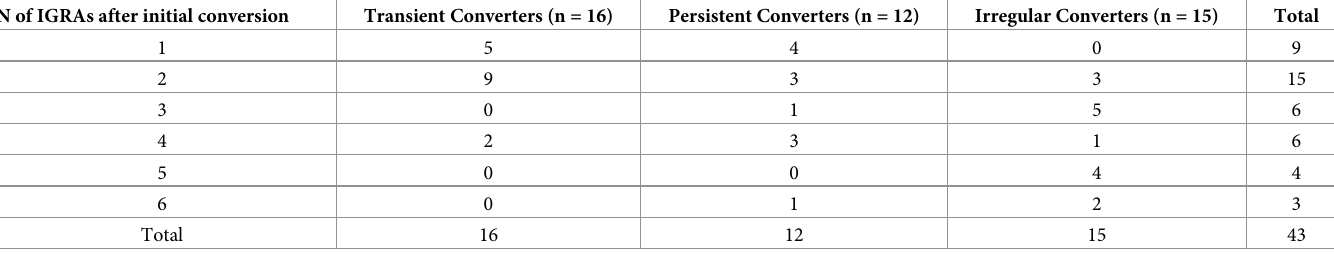
Table 6. Distribution of 3 IGRA conversion categories based on number of IGRAs performed after initial conversion. N of IGRAs after initial